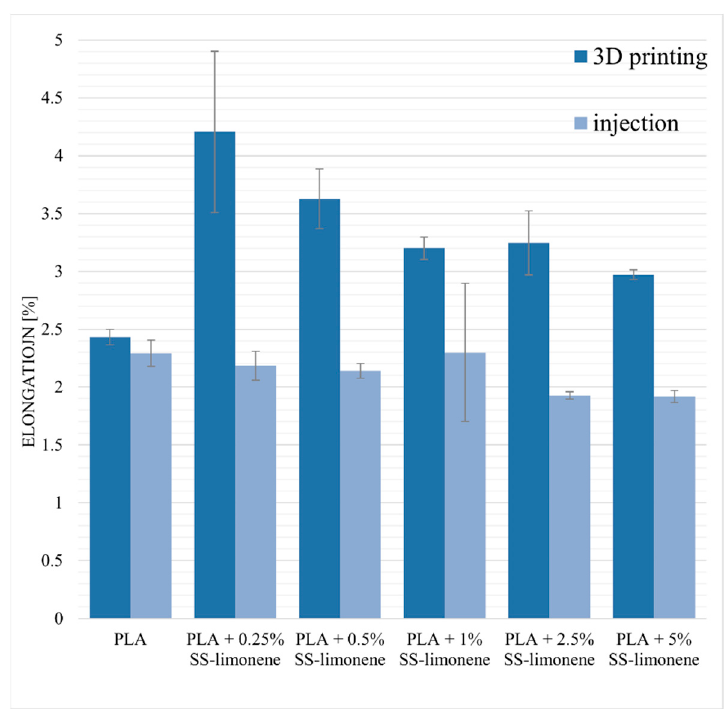
Figure 9. Elongation at maximum load of SS-Limonene/PLA in 3D printing and injection moulding.